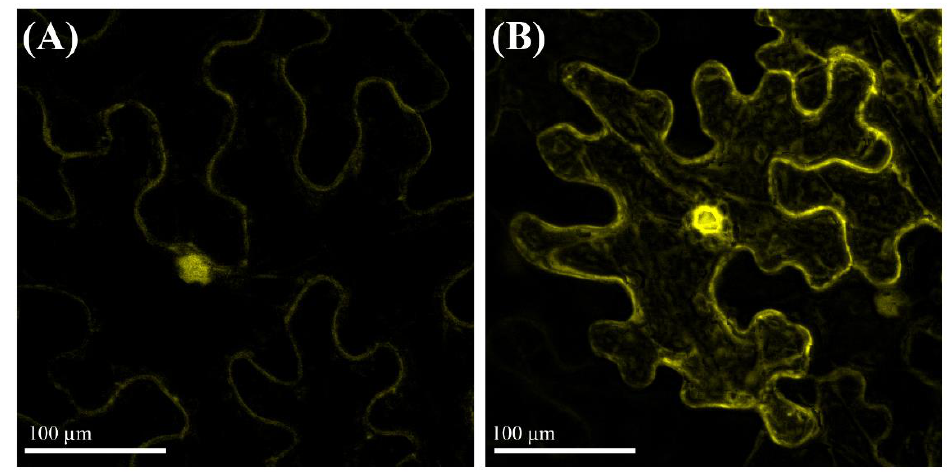
Figure 3. Subcellular localization of Pv MT1A. The localization of the Pv MT1A protein was mon- itored in N. benthamiana leaves infiltrated with the 35S::YFP construct as a control ( A ) or with 35S::YFP: Pv MT1A ( B ) by means of confocal